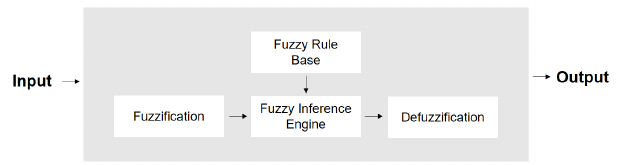
Figure 2. Structure and components of a Fuzzy